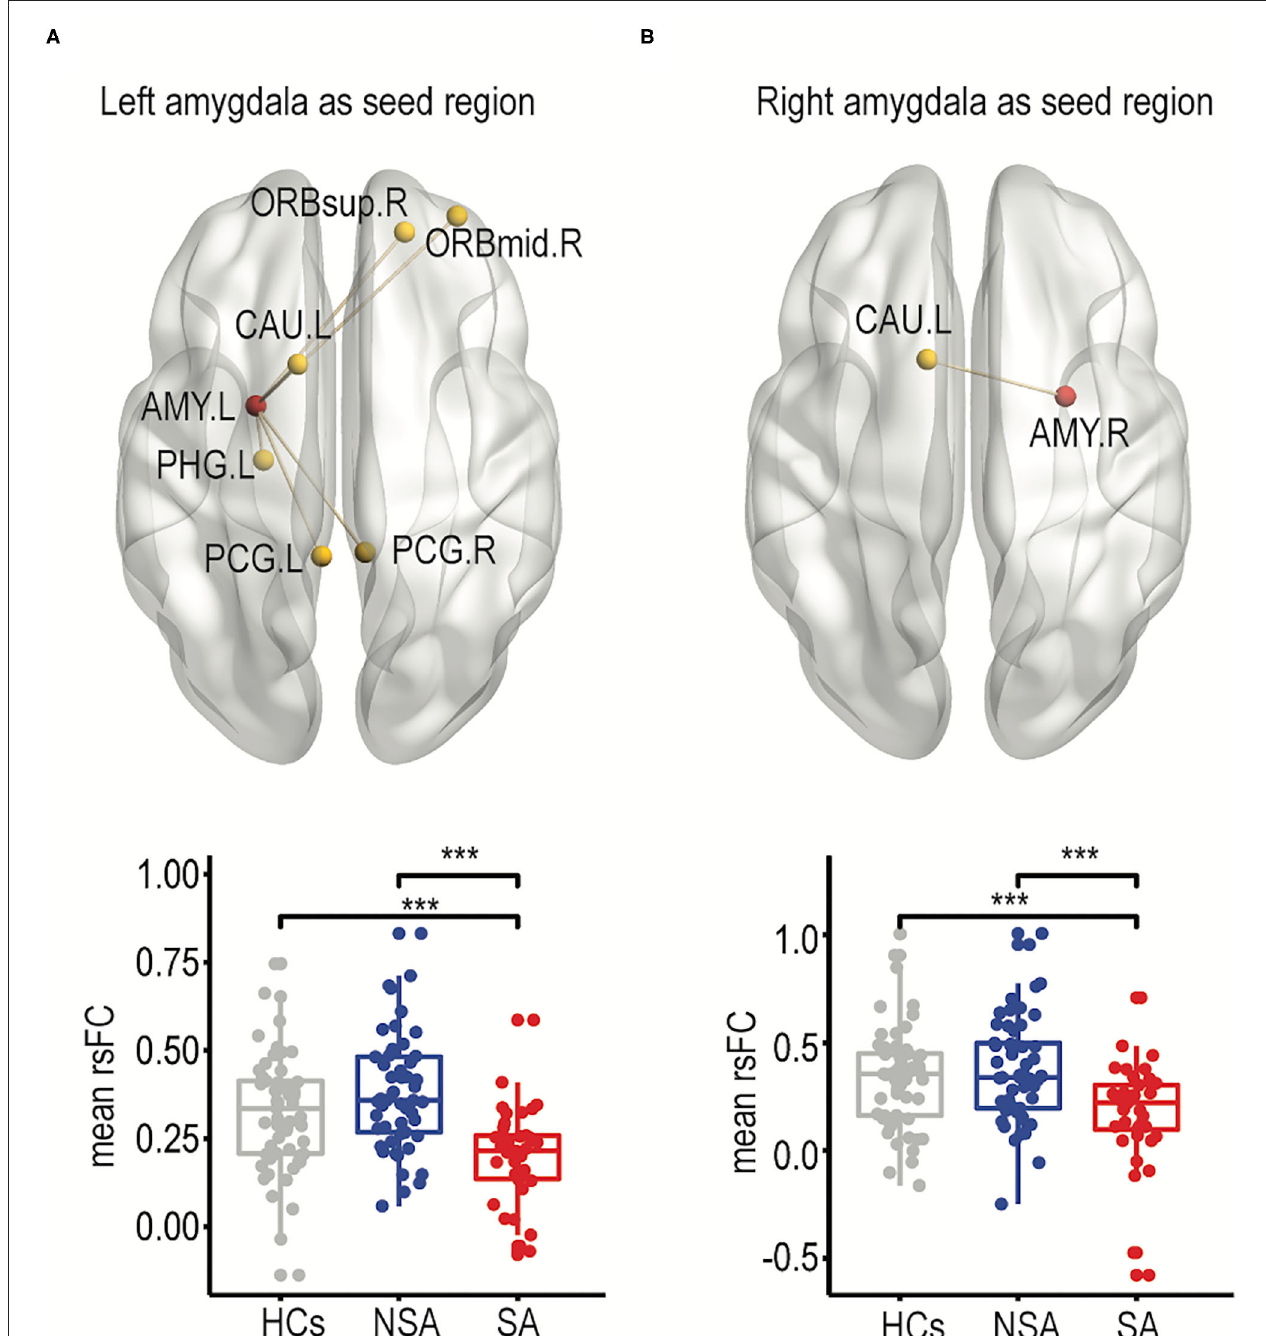
FIGURE 1 | Frontolimbic rsFCs comparisons between SA, NSA, and HCs. The significantly different resting-state functional connectivity between suicide attempters and non-suicide attempters was shown for the left amygdala as the seed region (A) and the right amygdala as the seed region (B) . In addition, the mean FCs among three groups were shown as box plotted as well (right panel). The significances of all comparisons were FDR corrected. *** p < 0.001. HC, healthy controls; NSA, bipolar II disorder depression patients without suicidal attempt; SA, bipolar II disorder depression patients with suicide attempt; AMY.L, left amygdala; AMY.R, right amygdala; ORBsup.R, right superior frontal gyrus (dorsolateral); ORBmid.R, right middle frontal gyrus (orbital part); PCG.L, left posterior cingulate gyrus; PCG.R, right posterior cingulate gyrus; PHG.L, left parahippocampal gyrus; CAU.L, left caudate nucleus.